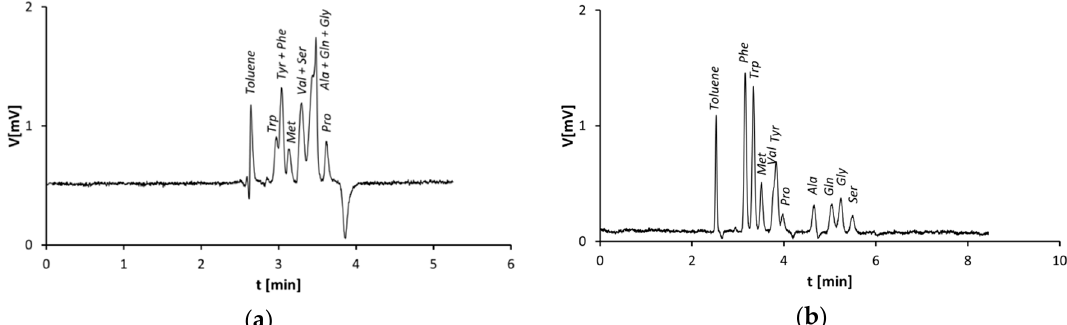
Figure 1. HILIC separation of ten amino acids. ( a ) plain silica monolithic capillary column; ( b ) MSA monolithic capillary column prepared according to the literature [27]. Operating conditions: columns 150 × 0.1 mm; mobile phase: 75% ACN, 25% 25 mmol/L ammonium acetate at pH 4.5; flow rate 500 nL/min; UV detection at 210 nm.